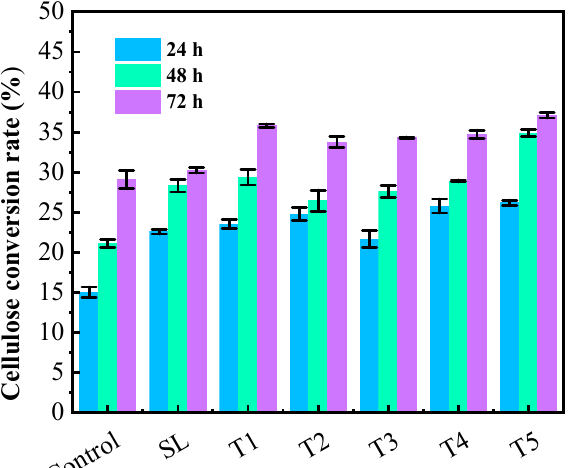
Figure 2. Effects of different compound additives on enzymatic hydrolysis of Avicel. SL—sophorolipid; T1—methanol + sophorolipid (C1 + SL); T2—n-butanol + sophorolipid (C4 + SL); T3—n-pentanol + sophorolipid (C5 + SL); T4—isoamyl alcohol + sophorolipid (I5 + SL); T5—n-decanol + sophorolipid (C10 + SL). Experaments were determined in use with 10% ( w / v ) Avicel as substrate with cellulase of 10 FPU/g substrate and W 63 crude enzyme protein of 40 mg/g substrate hydrolysis for 72 h.